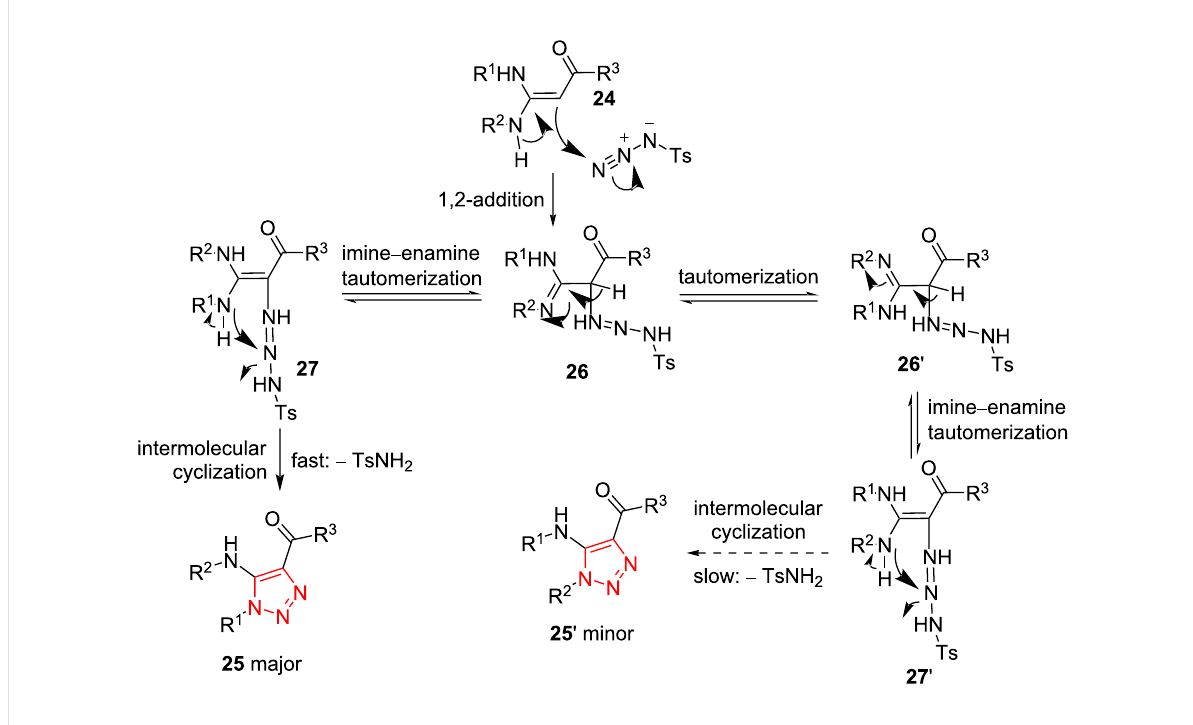
Scheme 11: A reasonable mechanism for the synthesis of fully decorated 1,2,3-triazole compounds 25 through the regioselective addition and cycli- zation reaction of EDAMs 24 with p -methylbenzenesulfonyl azide.